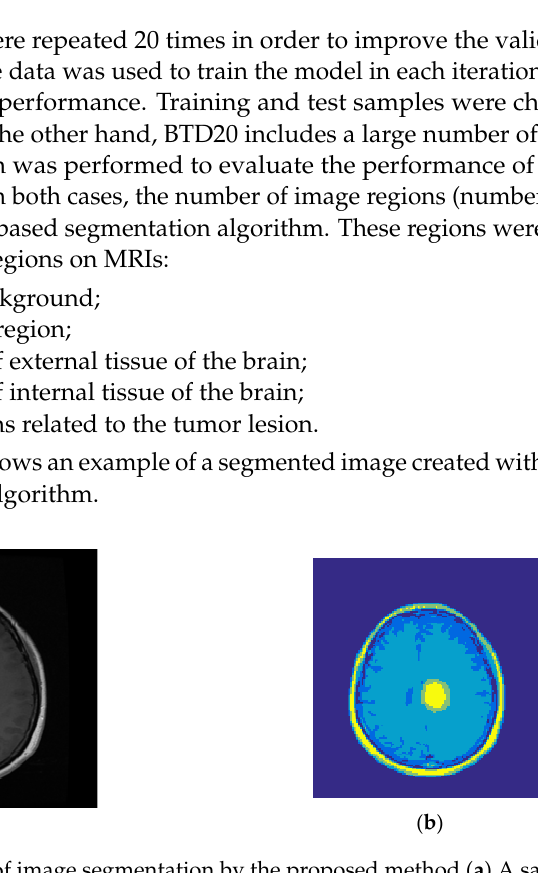
( b ) Figure 5. ( a ) The colormap, and ( b ) the surface plot of the features extracted through SVD algorithm . In Figure 5a, features are displayed as columns of the feature matrix and samples are displayed as its rows. In this matrix, the lower half corresponds to features extracted from normal samples and the upper half corresponds to tumor samples. As it is clear in Figure 5, the first columns of the extracted feature matrix show more obvious differences between the two target classes, and this difference decreases as we progress through the extracted features. This attribute, shows that the feature extraction algorithm used in the proposed method can efficiently rank the features. Thus, the features that can show the difference between the target classes more clearly are prioritized. Figure 6 shows the distribution of samples belonging to each of the two target classes based on the first three features ex- tracted by the SVD algorithm.